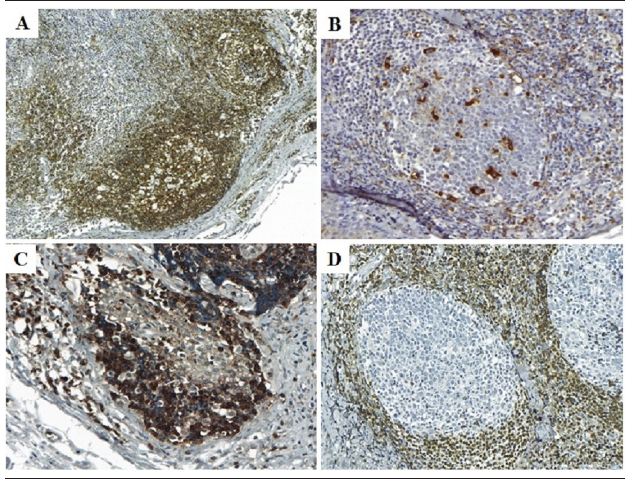
FIGURE 3 – Immunohistochemical analysis of lymphoid hyperplasias A) immunopositivity in lymphoid follicles for CD20, exhibiting greater immunoreactivity in the mantle zone relative to the germinal center; B) immunoreactivity for CD68 in macrophages located in both lymphoid follicles and parafollicular regions; C) CD3 with evident immunolabeling in parafollicular regions; D) immunostaining for Bcl-2 in the mantle zone and parafollicular regions, abscence of positivity in the germinal center of follicles. Bcl-2: B-cell lymphoma